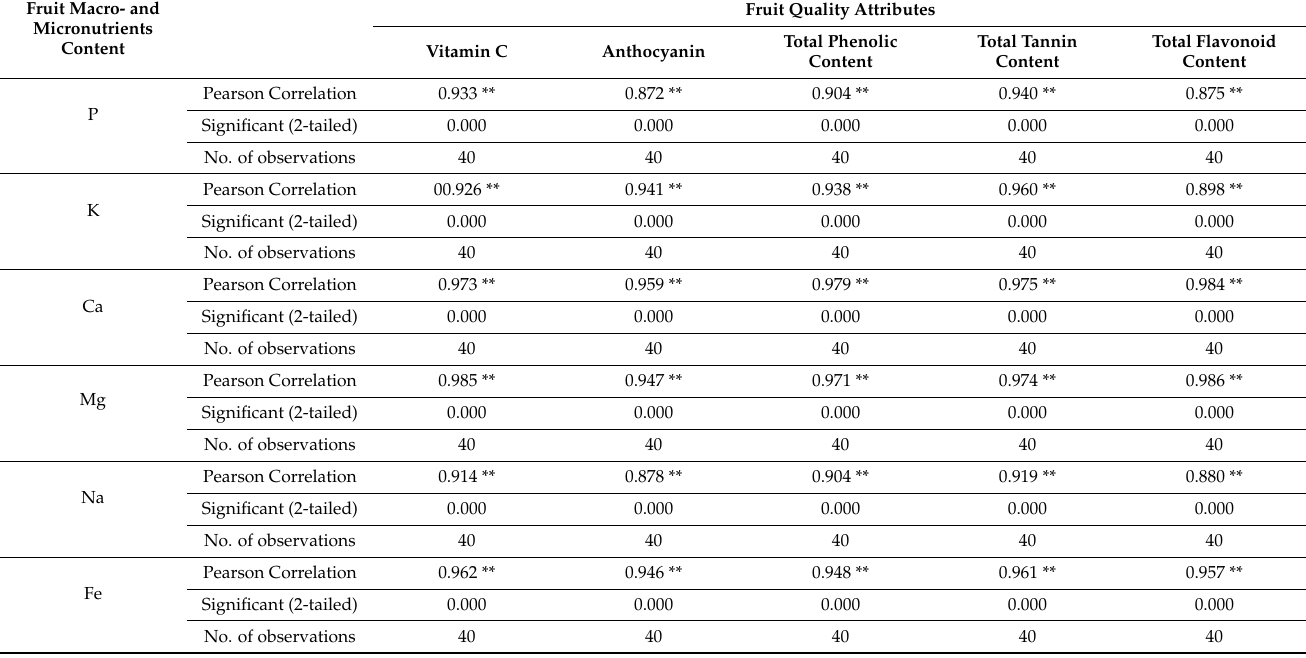
Table 8. Correlation coefficients among investigated parameters in pomegranate